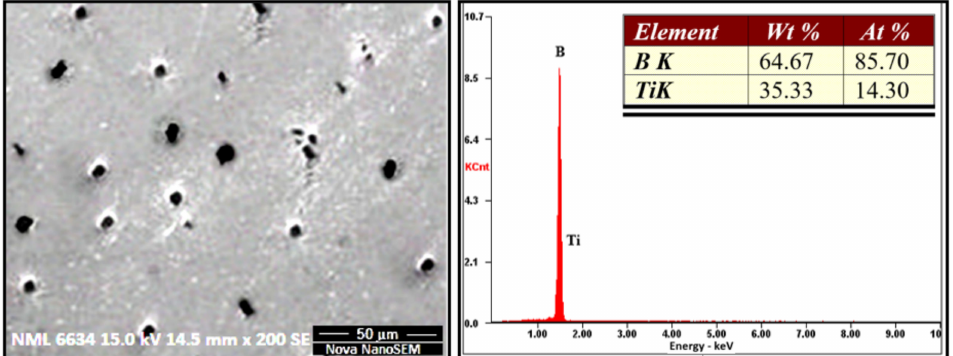
Figure 7. SEM and EDAX of LM4 + 3 wt.% TiB 2 composite sample.